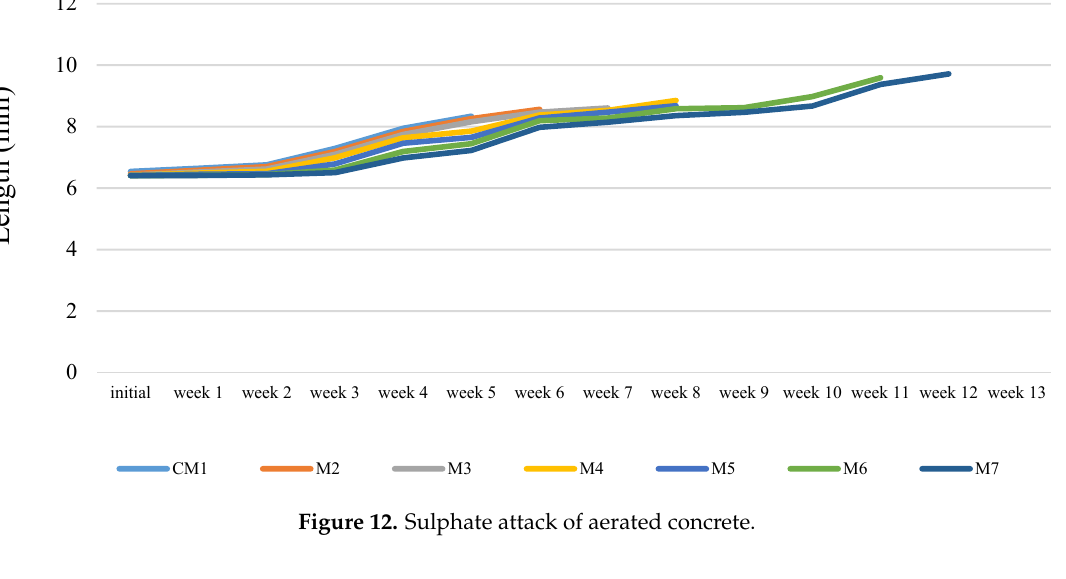
Figure 11. Corrosion potential (mV) of aerated concrete (D—days).